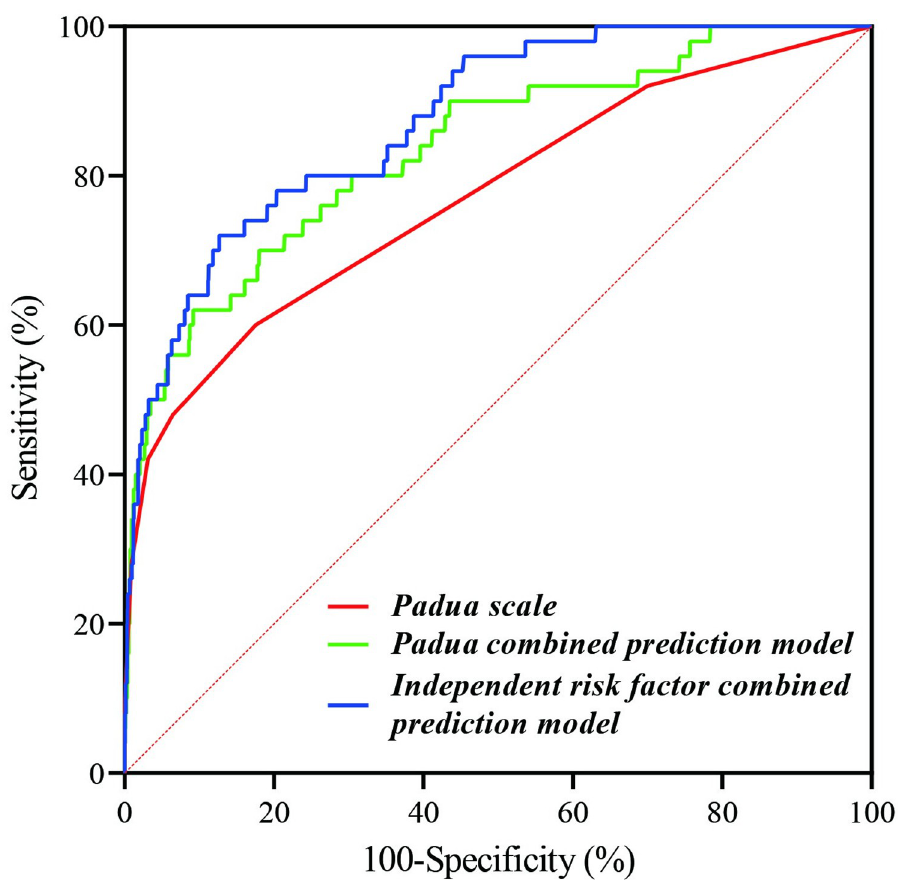
Fig 2. ROC curves of the Padua scale, Padua combined-prediction model, and independent risk factor-combined prediction model. Padua combined prediction model refers to the Padua scale combined with D-D and serum albumin. The independent risk factor-combined prediction model refers to the combination of five risk factors as follows: a hospital stay > 3 days, previous VTE history, APS, high D-D, and low serum albumin levels.